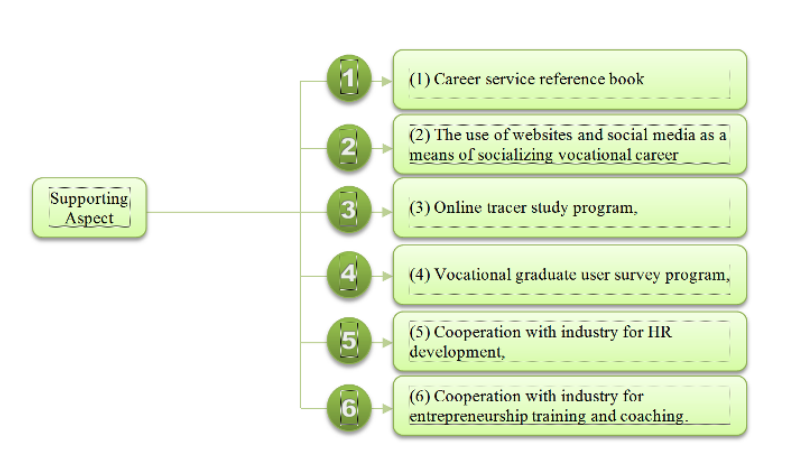
Figure 8: Supporting Aspects of Vocational Career